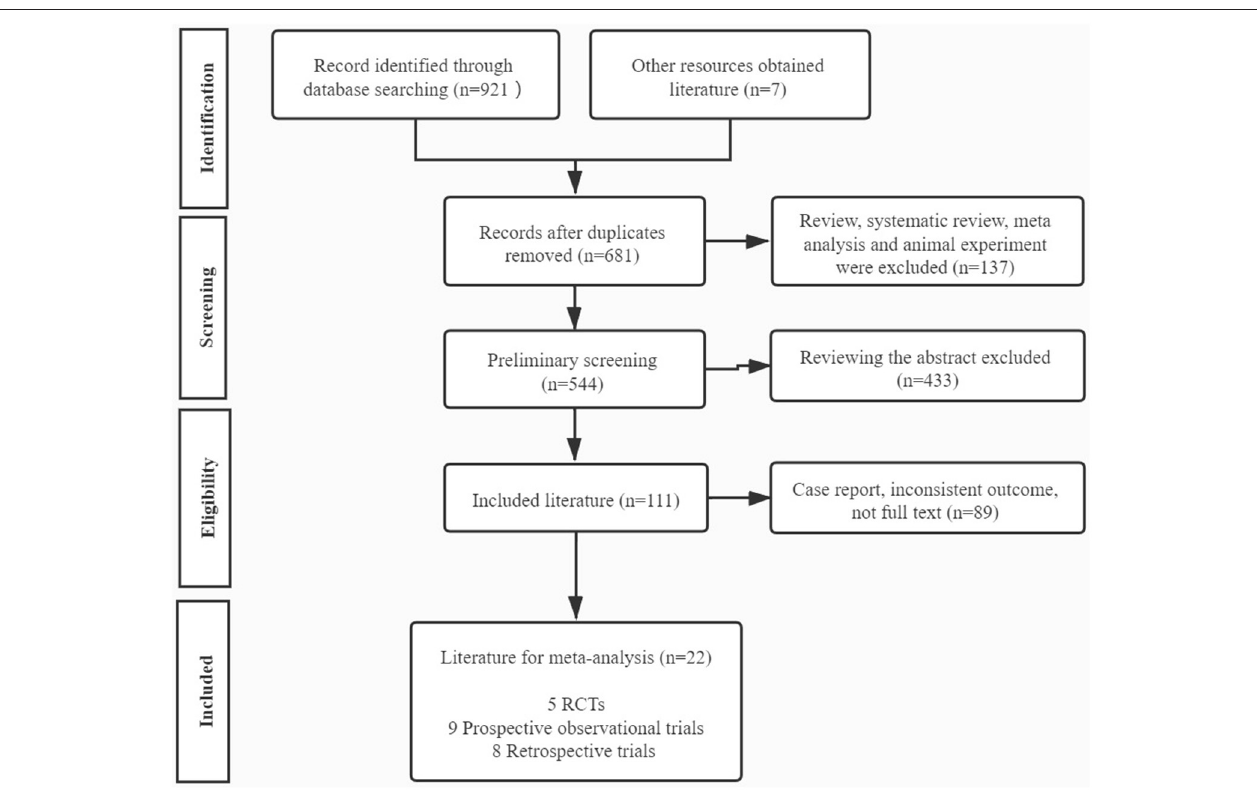
FIGURE 1 | Flowchart of the search method and